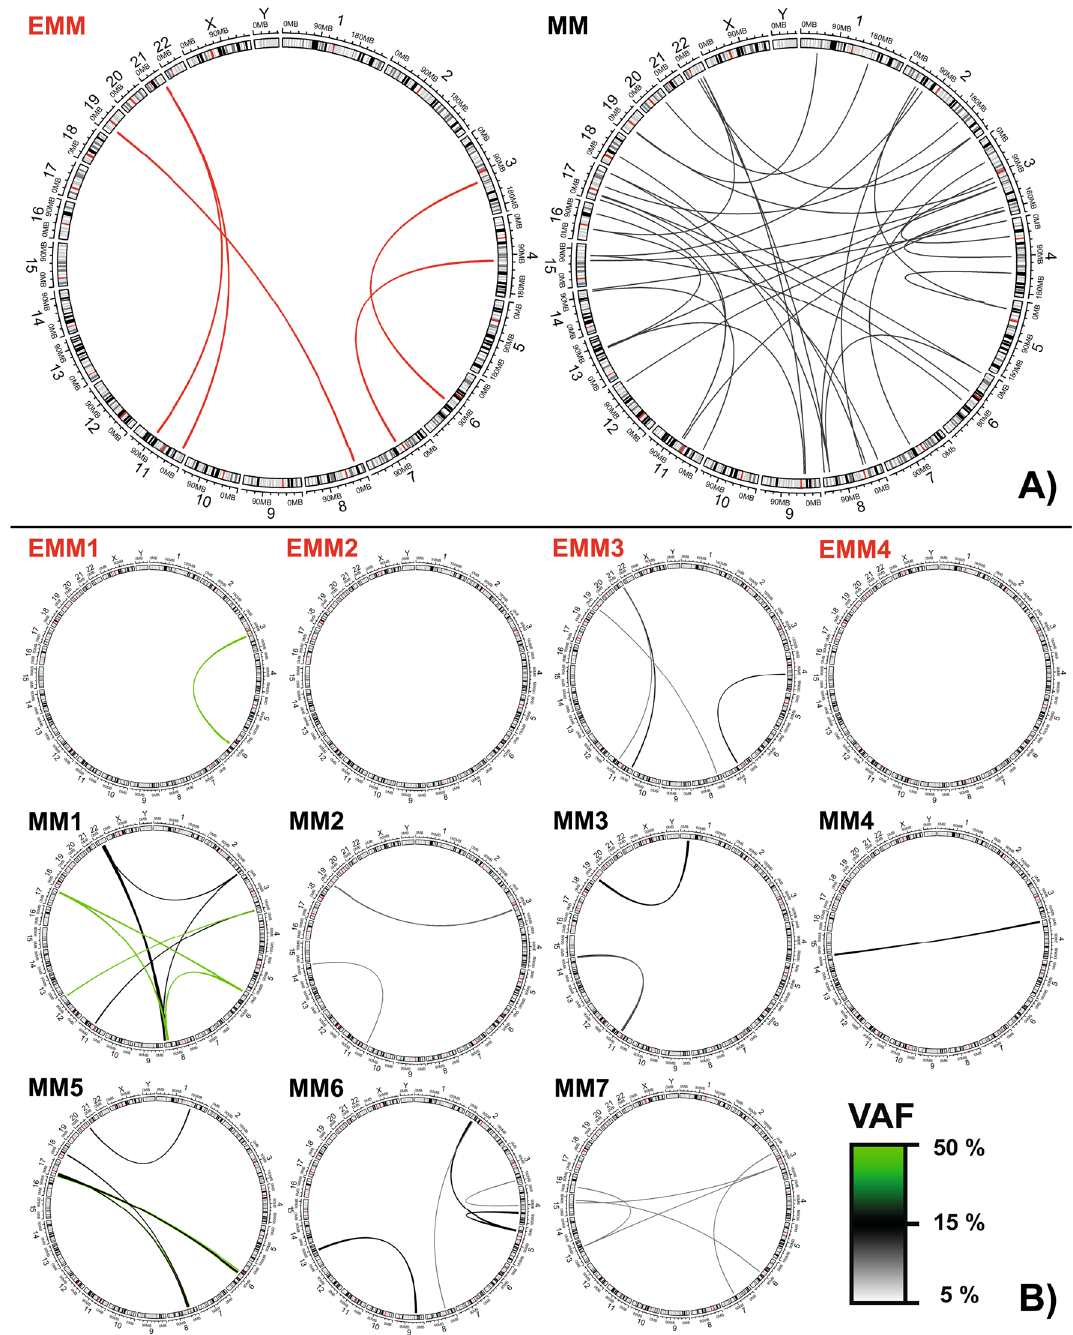
Figure 3. Distribution of chromosome translocations in EMM (red lines) and MM (black lines) patients. Large circos plots ( A ) show the sum of translocation in EMM and MM groups; ( B ) small circos show detected translocations in a particular patient. The VAF of each translocation is denoted by the thickness and colour of the line (key bottom right). SVs were visualised using circos plots 28